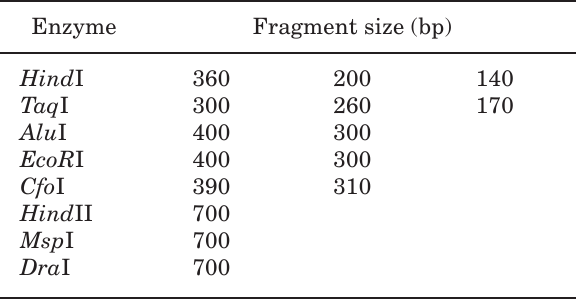
Table 5. Restriction fragment analysis of the rDNA spac- er digested with different enzymes in Phellinus torulo-